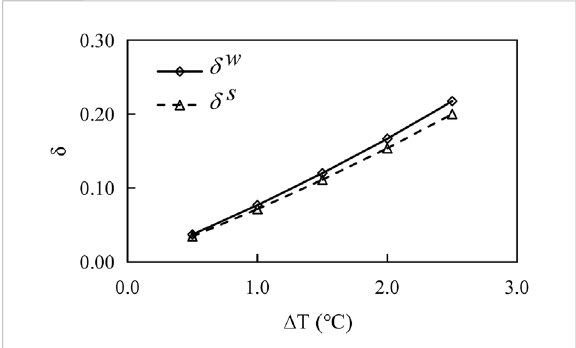
FIGURE 11 Relationship curve between the variation amplitude of groundwater temperature and the increment proportion of water required by the